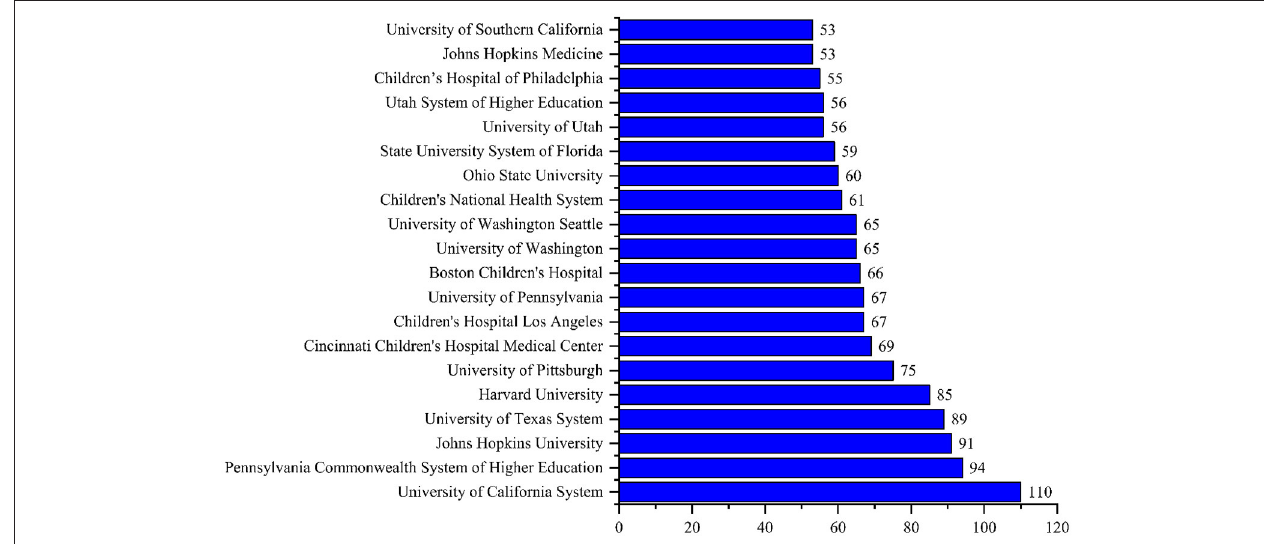
FIGURE 6 | Top 20 most active institutes in pediatric trauma research.